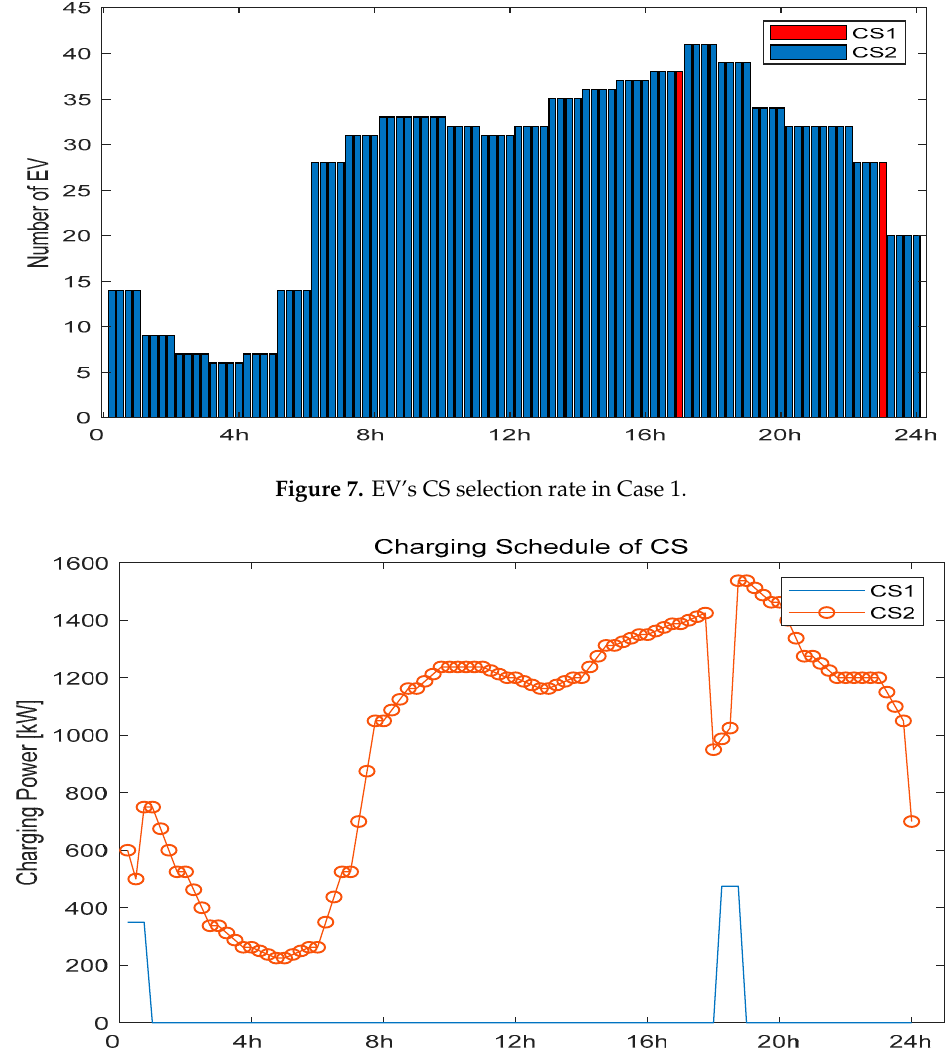
Figure 8. Charging schedule of CSs in Case 1.